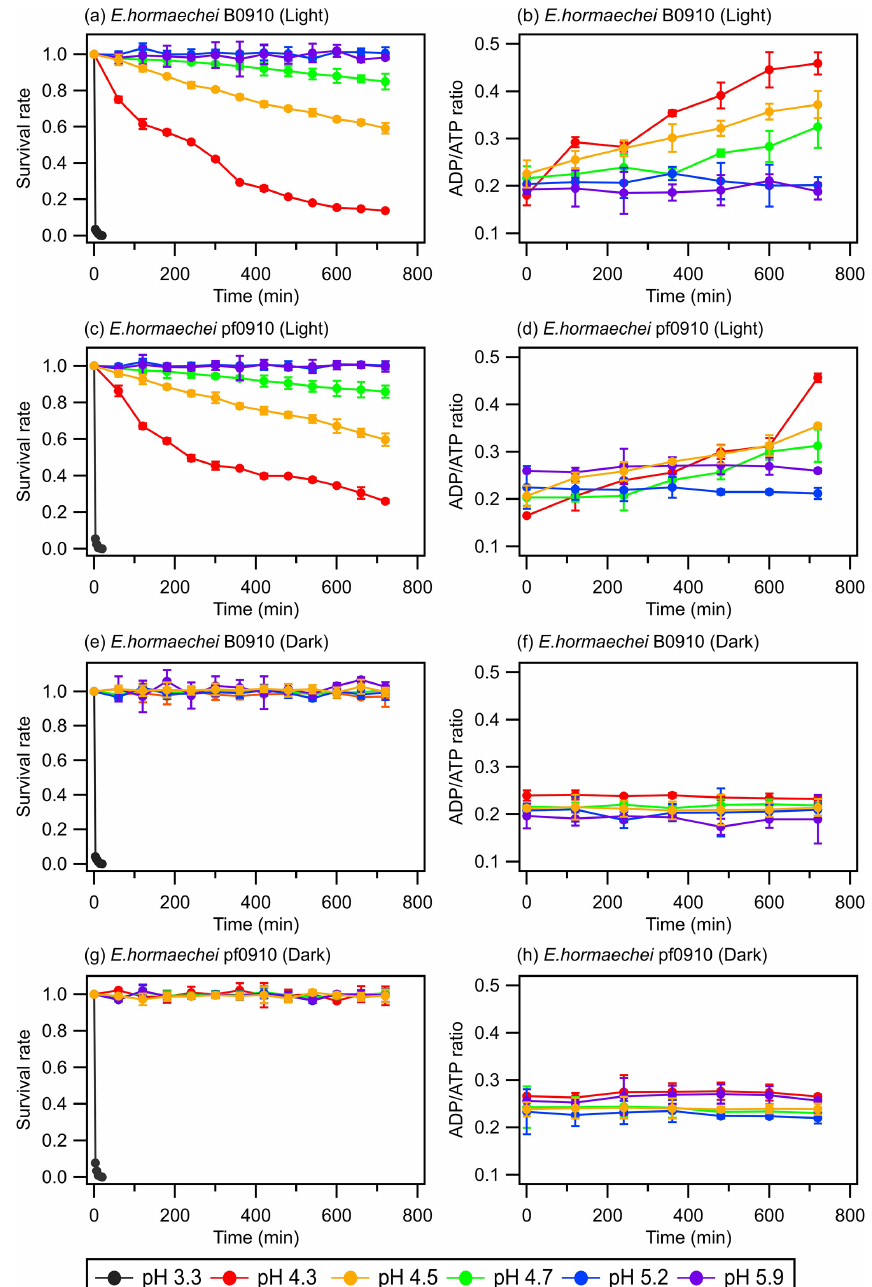
Figure 1. Survival rates and ADP / ATP ratios of the E. hormaechei B0910 and E. hormaechei pf0910 strains at pH3.3 to pH5.9 under illuminated and dark conditions over time. The survival rate is defined as the number concentration of culturable viable cells divided by the initial number concentration of culturable viable cells at time point 0min. Error bars represent 1 standard deviation from the mean of biological